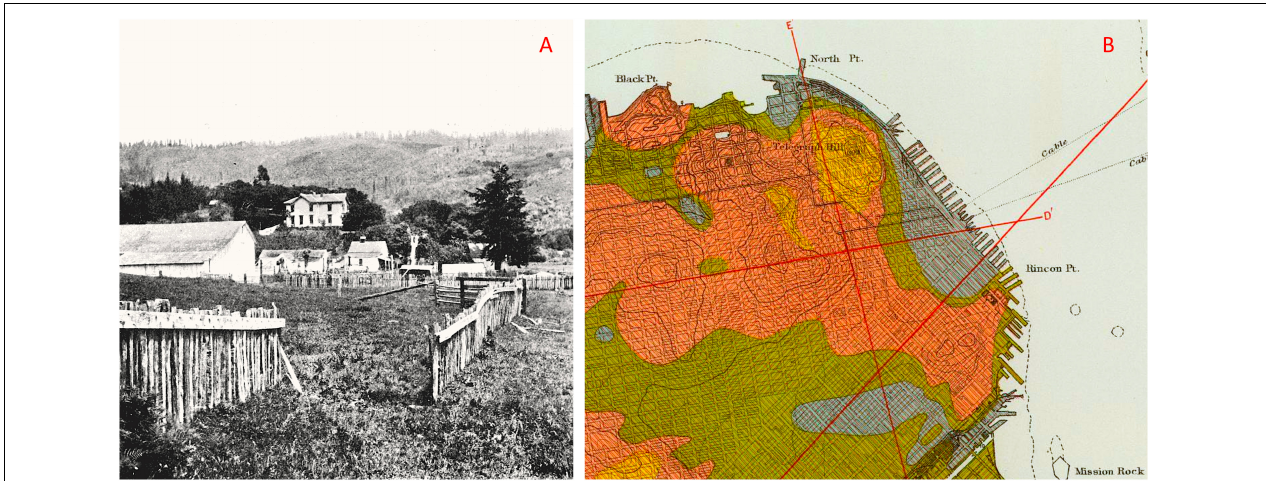
FIGURE 1 | The Lawson and Reid (1908) reconnaissance investigation of the 1906 San Francisco earthquake led to significant scientific and engineering advancements. (A) Reconnaissance photograph showing fence offset by earthquake surface fault rupture near Bolinas, Marin County, CA, United States. This observation led to the development of the theory of elastic rebound (Reid, 1910). (B) Excerpt of “Map of San Francisco showing apparent intensity of the earthquake shock” (Lawson and Reid, 1908) showing area of high intensity shaking revealing the modern engineering concept of non-linear site response and effects (Gray and green tones depict areas of highest local shaking intensity). Both images are reproduced from Lawson and Reid